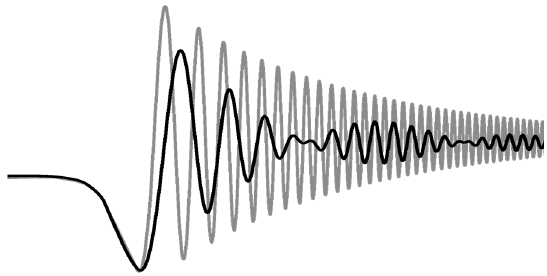
Figure18. Beating caused by differences in the frequency of rotation of precessing nuclei and RF excitation.